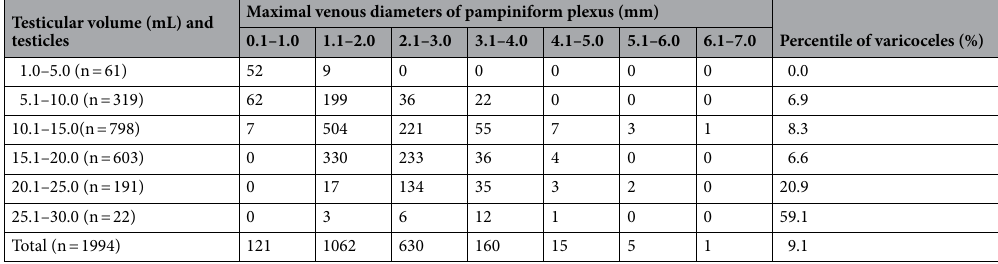
Maximal venous diameters of pampiniform plexus